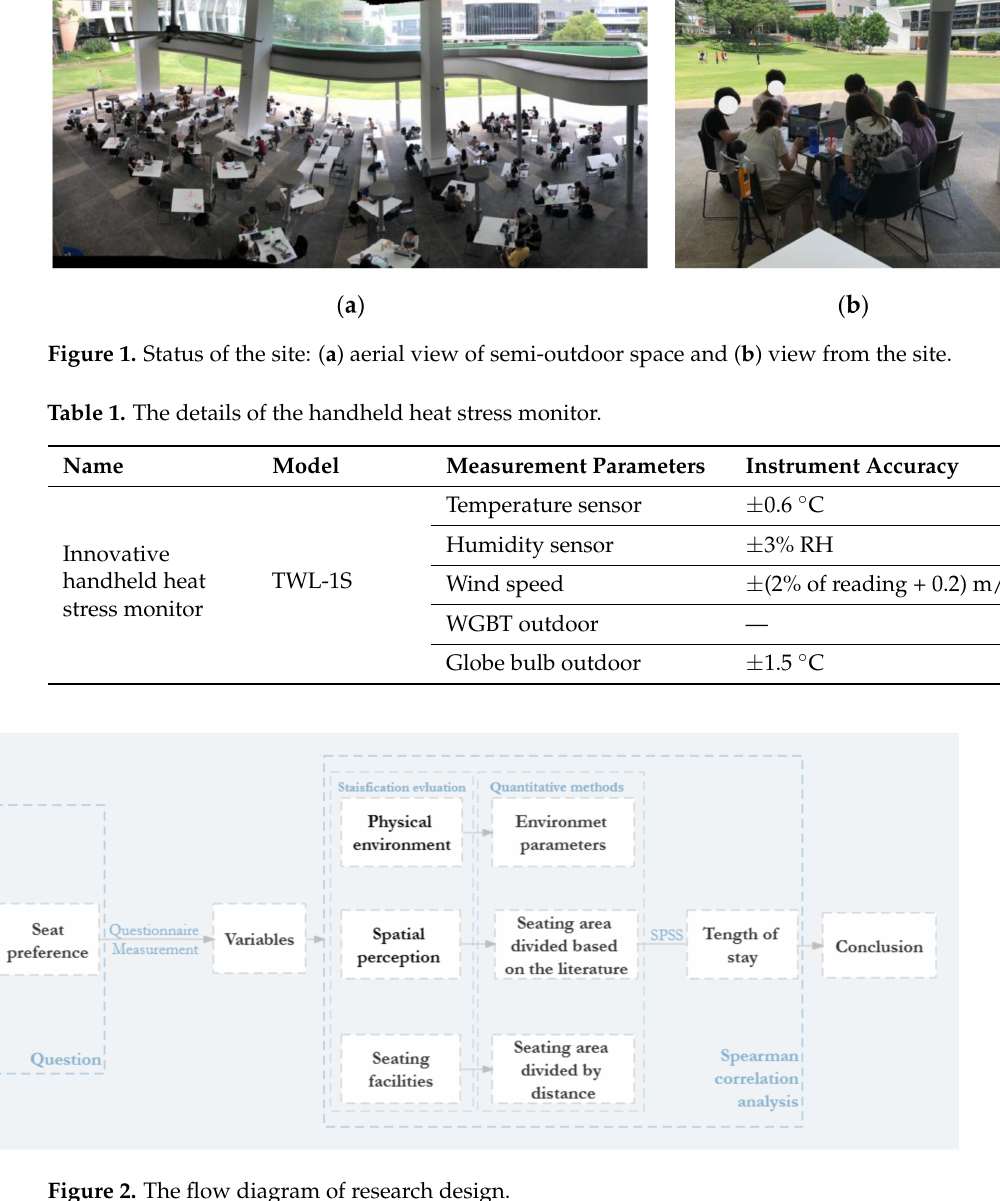
Figure 2. The flow diagram of research